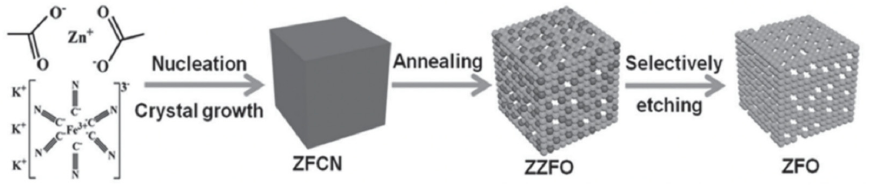
Figure 3. Scheme of ZZFO and ZFO synthesis process. Reprinted with permission from [71]. Copy- right 2015, John Wiley and Sons. Copyright 2015, John Wiley and